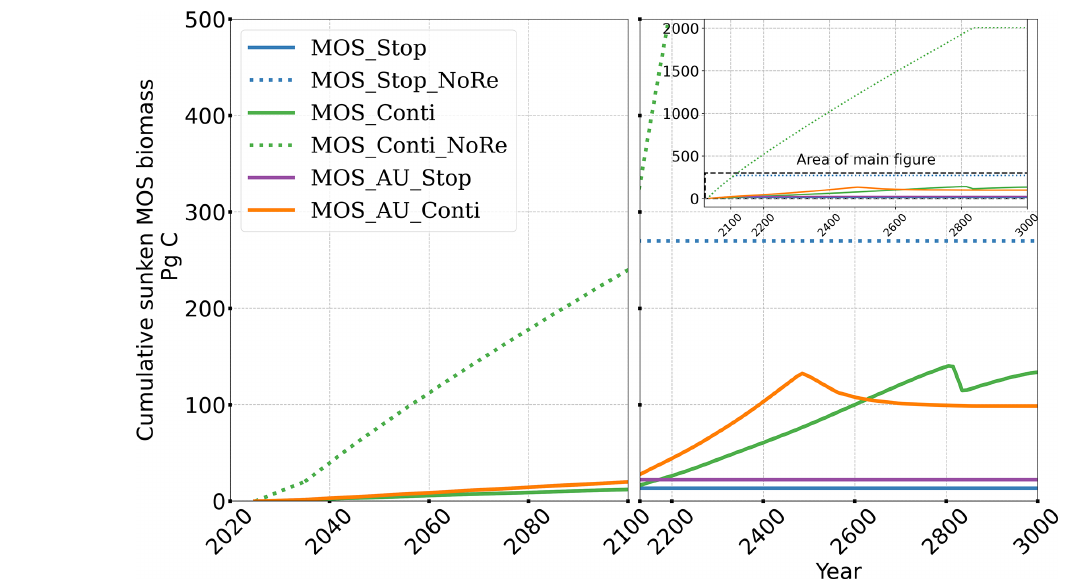
Figure 5. Temporal evolution of globally integrated sunken macroalgal biomass on the seafloor. Biomass generally increases with fertiliza- tion by AU. In the idealized zero-remineralization simulations, all sunken macroalgal biomass remains on the seafloor, and globally integrated sunken macroalgal biomass shows a monotonous